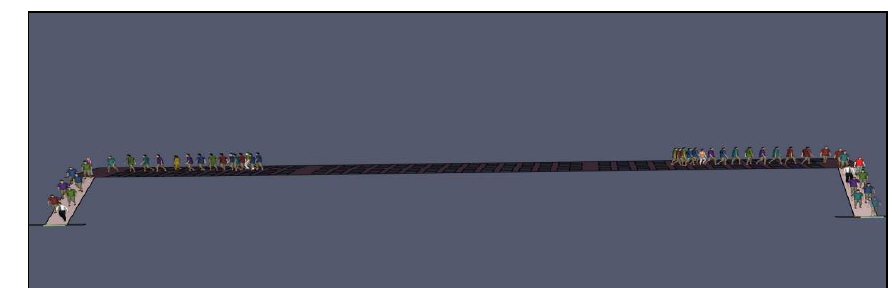
Figure 4 – Simulation moment for the second case of the first scenario at 170 seconds after the start of the